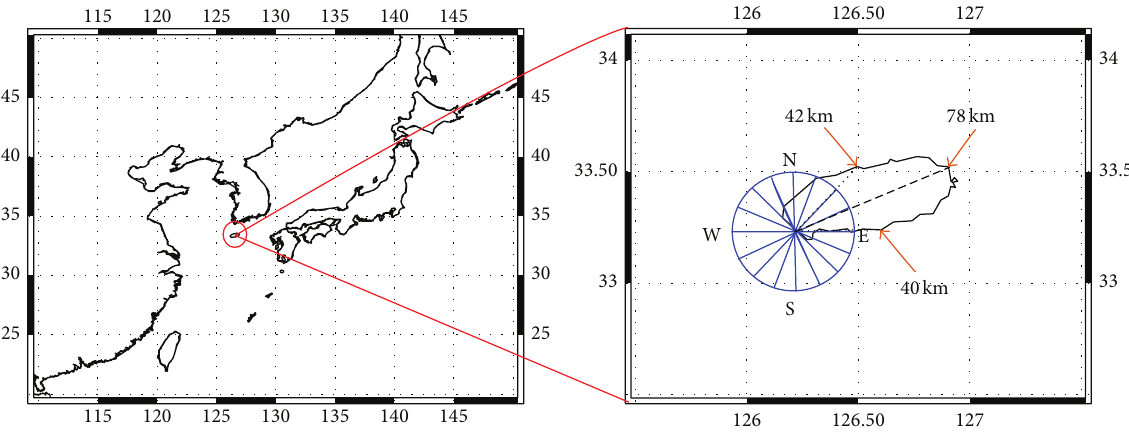
Figure 1: The location of Gosan site, Jeju Island in